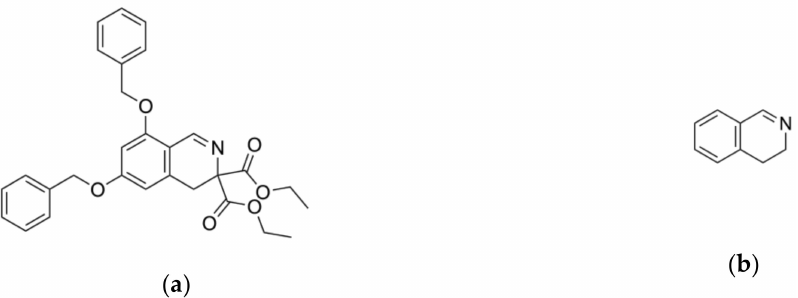
Figure 1. ( a ) chemical structure of diethyl 6,8-dibenzyloxy-3,4-dihydroisoquinoline-3,3-dicarboxylate and ( b ) chemical structure of the 3,4-dihydroisoquinoline sca ff